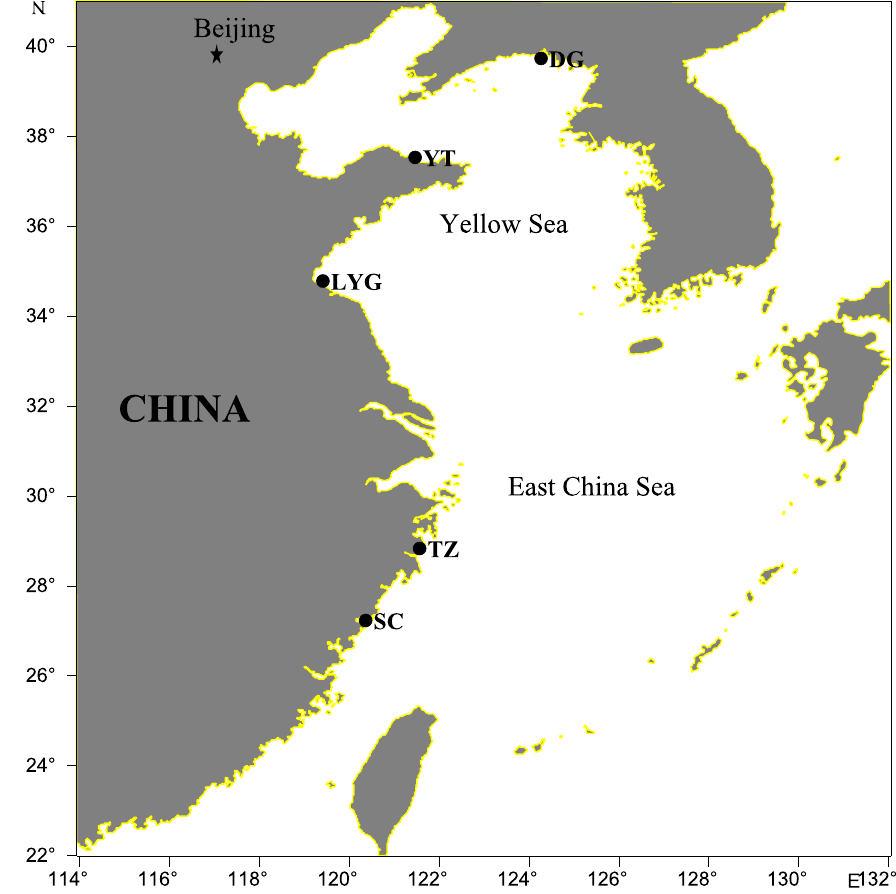
Fig. 1. Map of the Larimichthys polyactis sampled locations (indicated by circles). The abbreviations correspond to sampled location names, as indicated in text. DG: DongGang; LYG: LianYunGang; SC: ShaCheng; TZ: TaiZhou; YT: